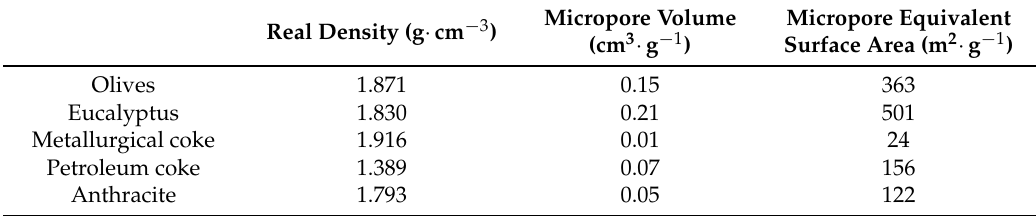
Table 8. Textural characterization of commercial reducers and bioreducers (750 ˝ C and 3 ˝ C ¨ min ´ 1